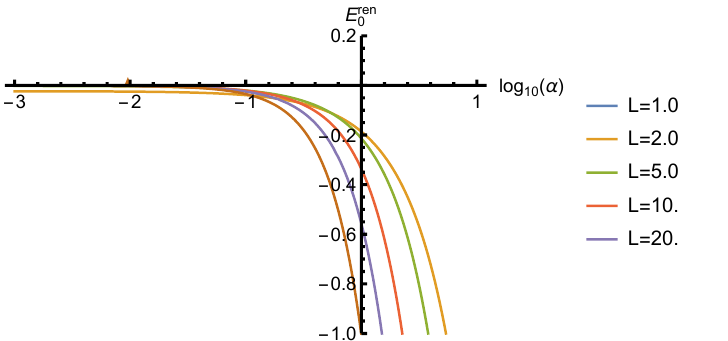
Figure 1. The vacuum energy E ren of a massive scalar field in a box with repulsive self-interaction. 0 All quantities are given in units of the mass m e